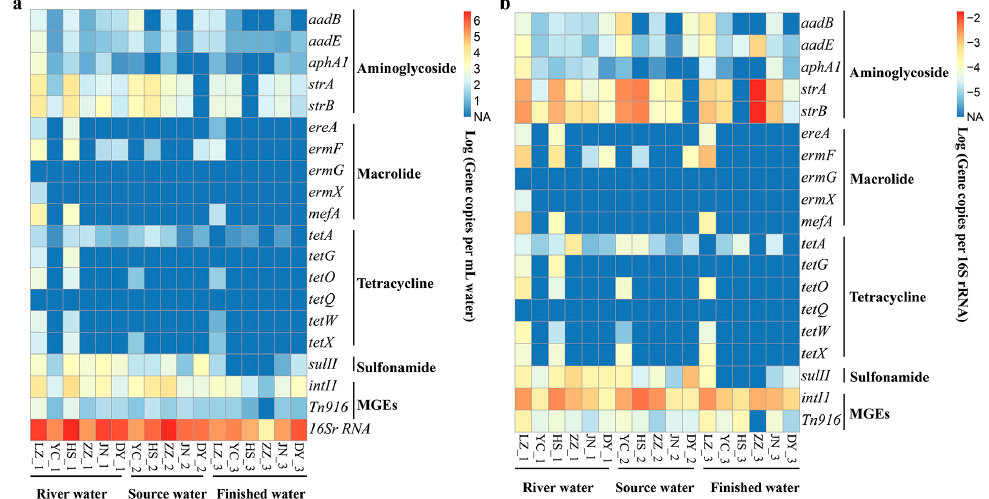
Figure 2. ( a ) Absolute and ( b ) relative abundances of the 17 ARGs, two MGEs, and 16s rRNA in water samples. Label under each column denotes sample site name followed by water type (1 is river water, 2 is source water, 3 is finished water).